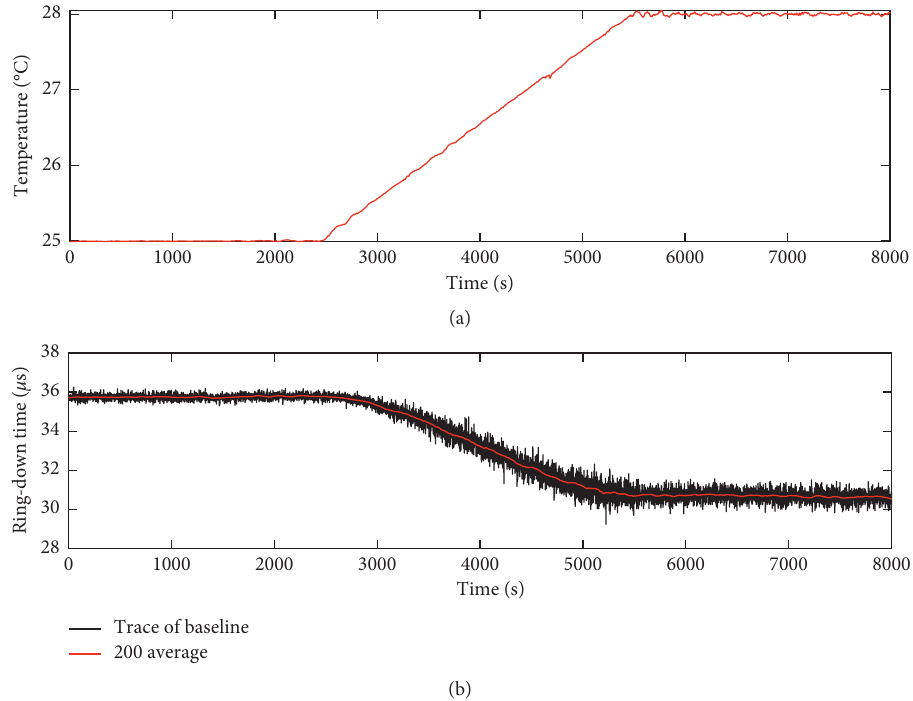
Figure 6: The variation of ring-down time with temperature. (a) Change of cavity temperature recorded by thermal controller. (b) Ring- down time at different